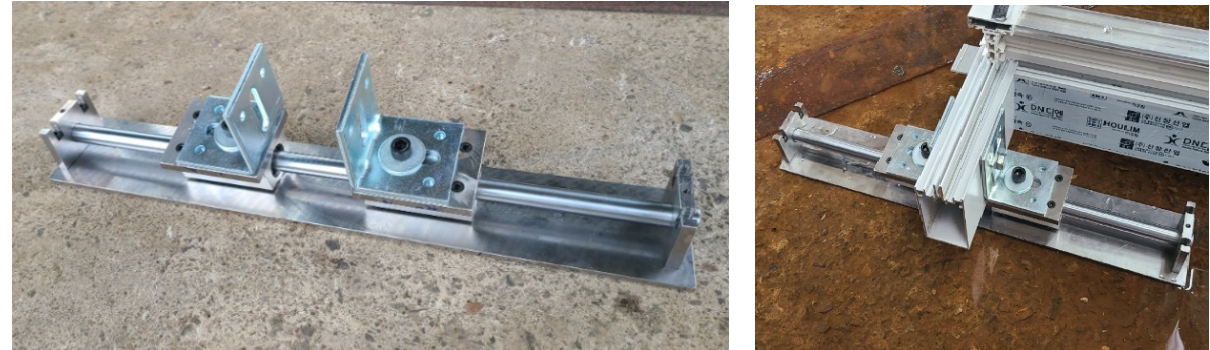
Figure 5. Seismic fastener prototype ( X -axis).